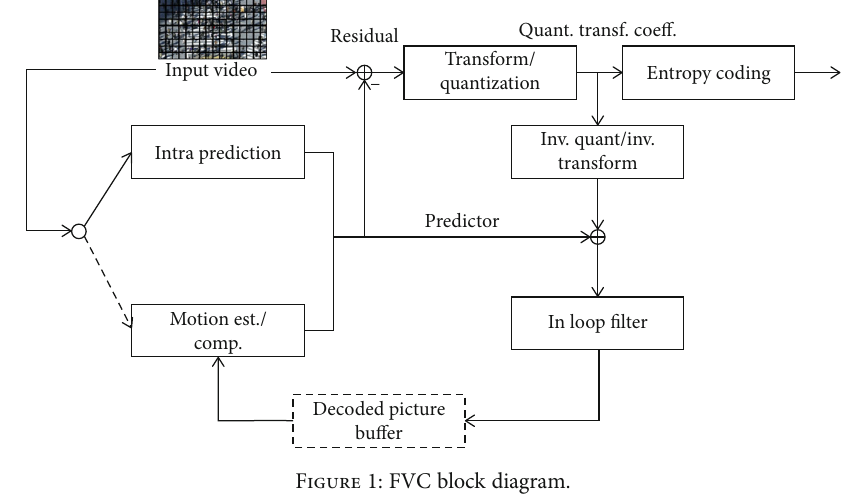
Figure 1: FVC block diagram.